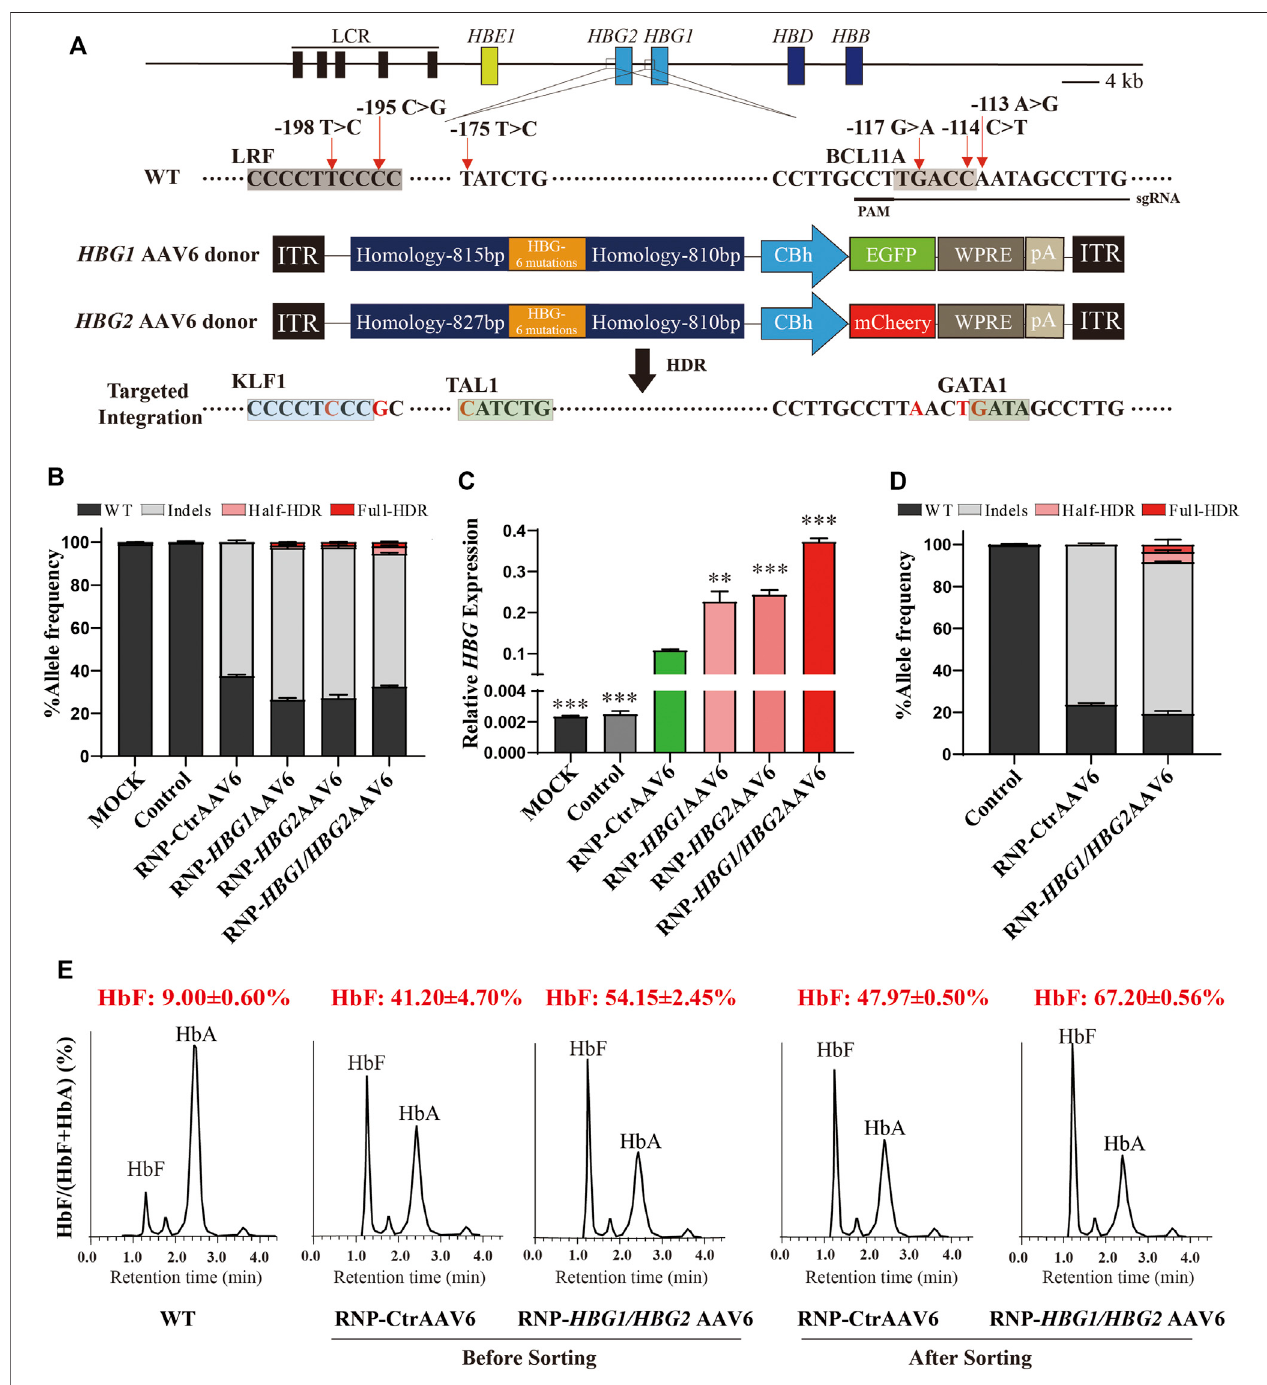
FIGURE 1 | Genome editing of HBG1/HBG2 promoters reactivate γ -globin expression in HUDEP-2 cells. (A) Schematic view of targeted genome editing at the HBG1/HBG2 promoters using CRISPR/Cas9 and AAV6. Guide RNA spacer sequence and protospacer adjacent motif (PAM) are underlined. Site-speci fi c HPFH mutationsareindicatedbyaredarrow.ADSBstimulatesHDRusingtheAAV6homologousdonorasarepairtemplate.Legend:Orangeboxes, HBG1/HBG2 promoters with six speci fi c HPFH mutations; deep blue boxes, homology arms; green or red boxes, GFP or mCherry expression cassette. (B) InDels and HDR frequencies measured by NGS after RNP electroporation and AAV6 transfection in HUDEP-2 cells. (C) γ -globin/ β -like globin mRNA expression determined by RT-qPCR. (D) GFP- positive population were sorted from the group edited by RNP combined with HBG1/HBG2 AAV6, or from the group edited by RNP combined with CtrAAV6. NGS analysis was performed to identify InDels and determine HDR frequencies. (E) The percentage of HbF in HUDEP-2 cells were determined by HPLC on day 8 of differentiation before or after GFP + sorting. The data in Figures 1B,D are presented as the mean ± SD, n = 2. In other fi gures, the data arepresented asthe mean ± SD, n = 3. Student ’ s t -tests were performed to analyse the data. *, p < 0.05; **, p < 0.01; and ***, p < 0.001 vs . RNP-CtrAAV6.